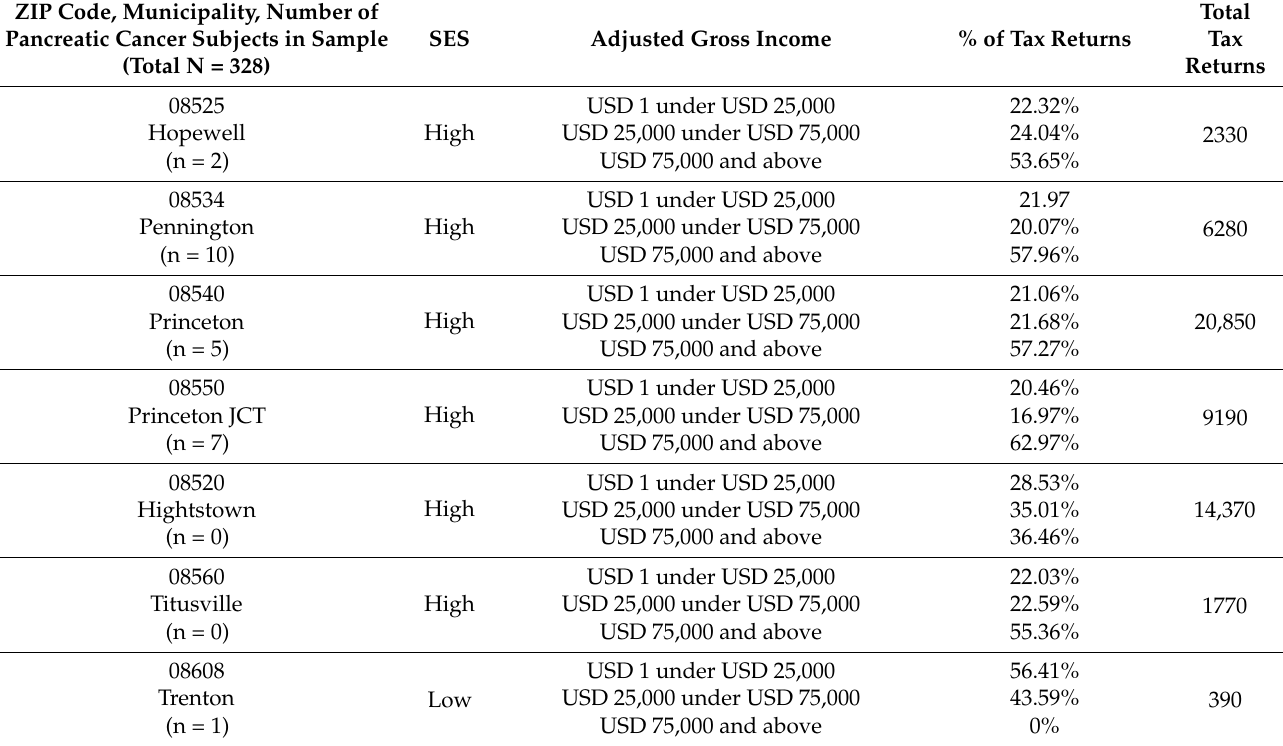
Table 1. Socioeconomic status (SES) strata created from ZIP code and adjusted gross income (AGI). Municipalities with their ZIP code, including proportion of tax returns (AGI from 2017) and their adjudication according to socioeconomic status in low (<USD 25,000), mid (USD 25,000–USD 75,000), or high (>USD 75,000) income brackets. The overall distribution of the subjects across the study was as follows: low SES 35.7% (n = 121 subjects), mid SES 37.2% (n = 126 subjects), and high SES 27.1% (n = 92 subjects). We recoded the cancer database into SES strata and analyzed several clinically relevant